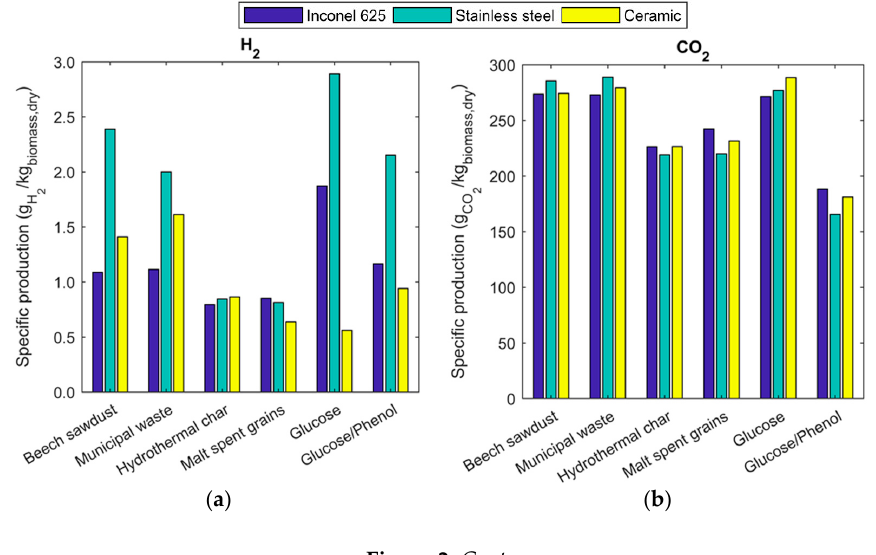
Figure 1. Gas composition (molar fractions, dry basis) of the gas produced in the SCWG experiments: ( a ) H 2 : ( b ) CH 4 ; ( c ) CO 2 ; ( d ) C 2 H 6 ; ( e ) C 3 H 8 ; ( f ) C 4 H 10